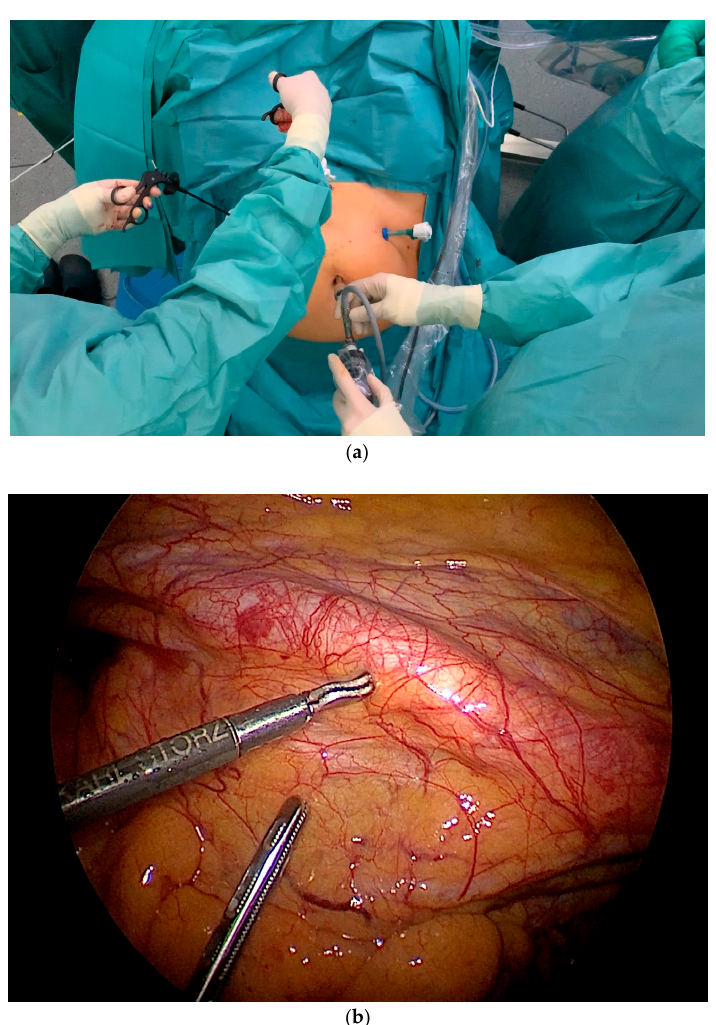
Figure 7. Trocar placement, the positioning of the surgical team, and operative findings. ( a ) The surgeon is to the patient’s left, and the first assistant to the patient’s right. The central trocar is inserted through the umbilicus. The working trocars are placed in the pelvis laterally and in the suprasymphysiary position. The first assistant holds the camera and uses the central trocar. The first assistant uses the right lateral trocar to provide assistance. The surgeon uses the left lateral and middle trocar. The middle working trocar should not be placed in the usual suprasymphysiary position, as this will inevitably cause the surgeon to work in his own direction. The middle trocar should be placed midway between the symphysis and the umbilicus. In order to avoid intraabdominal interference, the middle trocar should not be placed too close to the optical trocar. ( b ) Laparoscopic cranial view. Iliac vessels at the entrance to the right-sided pelvis. The ureter crosses the artery.